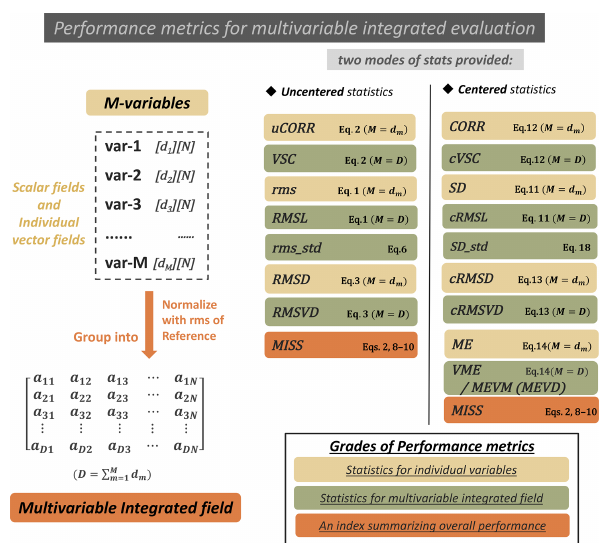
Figure 1. General idea and performance metrics of the improved MVIE. The left-hand column illustrates the general idea of the MVIE. Two modes of statistics are provided for evaluation: uncen- tered statistics (middle column) and centered statistics (right-hand column). In each mode, the statistics are sorted into three grades: statistics for individual variables, statistics for the multiple field, and a summary index. The right-hand side of the statistics box is its